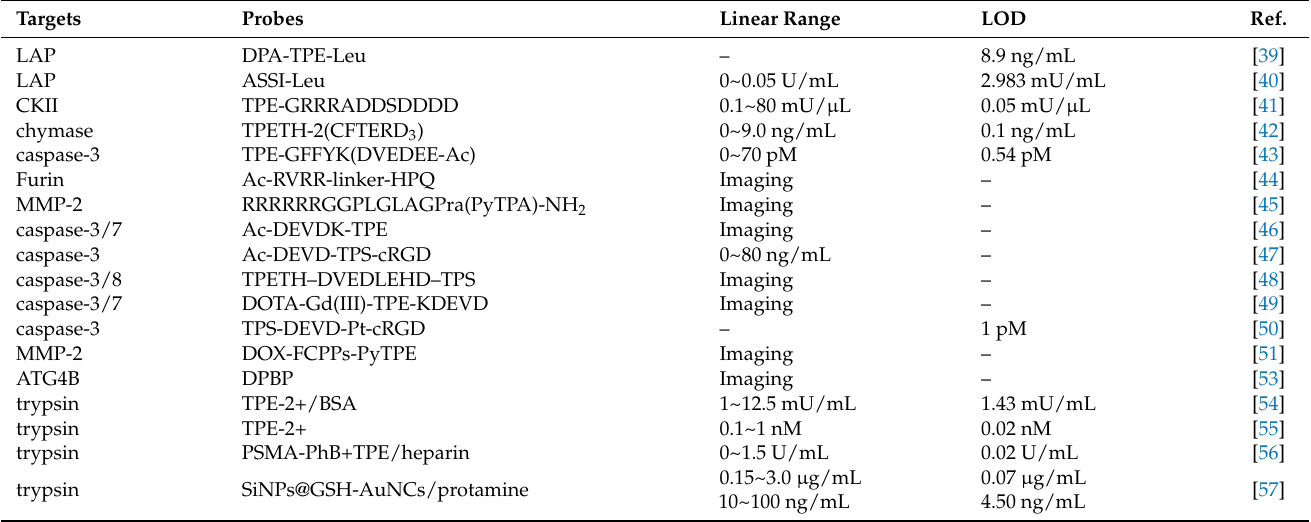
Table 1. Overview on AIE-based methods for the detection and imaging of different